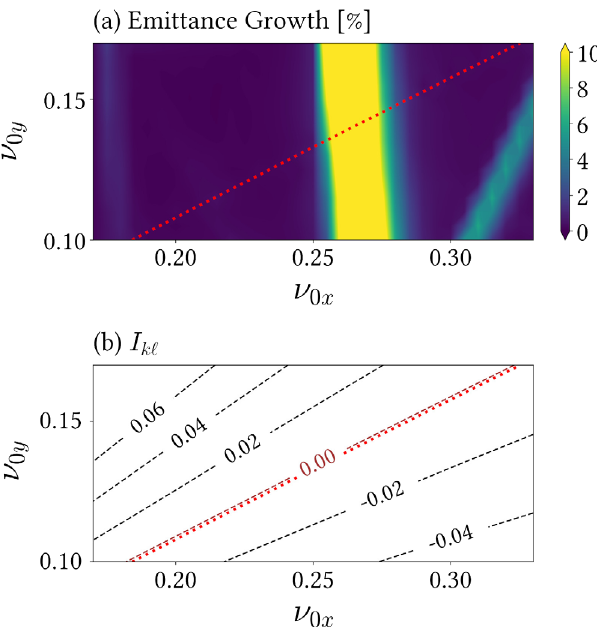
FIG. 8. PIC results on the suppression of a third-order differ- ence resonance line. (a) Tune diagram based on W ARP simu- lations with the initially equipartitioned Gaussian beam. The simulation parameters are the same as employed in Fig. 6 except that we have now switched a third-order error field ð ∝ x 3 − 3 xy 2 Þ on. The amplitude of the nonlinear external field is one percent of the linear focusing field ’ s. (b) Contour plot of the quantity I k l defined by Eq. (12) under the equipartitioning condition. The numbers on the picture indicate the values of I k l in units of mm · mrad. The red dotted line is the position of the coherent resonance band predicted by Eq. (8) with ð k; l ; n 0 Þ ¼ ð 1 ; − 2 ; 0 Þ . If we assume that C 3 ¼ 0 . 875 [20], the coherent resonance band predicted by Eq. (8) is positioned along the red dotted line that almost perfectly agrees with the line of I k l ¼ 0 . This supports the theoretical expectation that the coherent tune-shift factor is smaller than